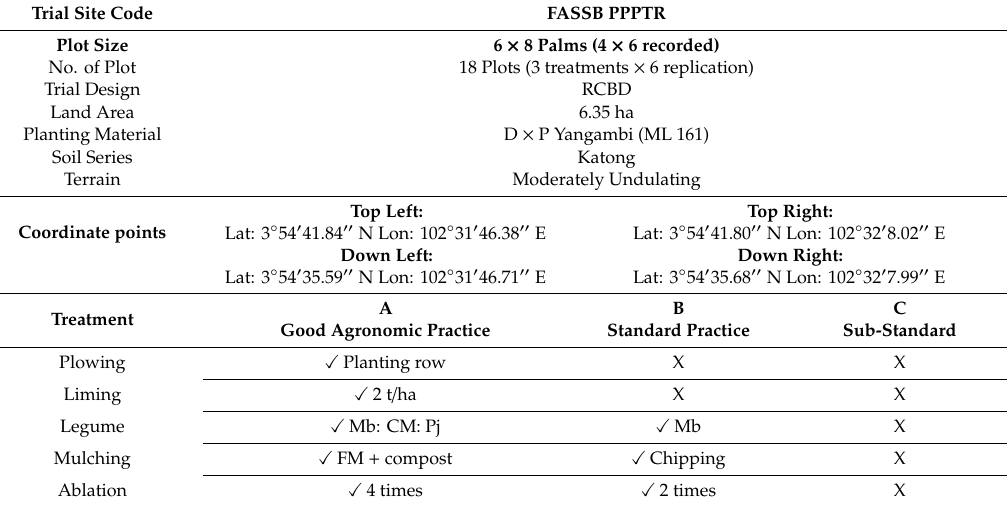
Table 2. The trial layout of the study area and the di ff erent agricultural practices.